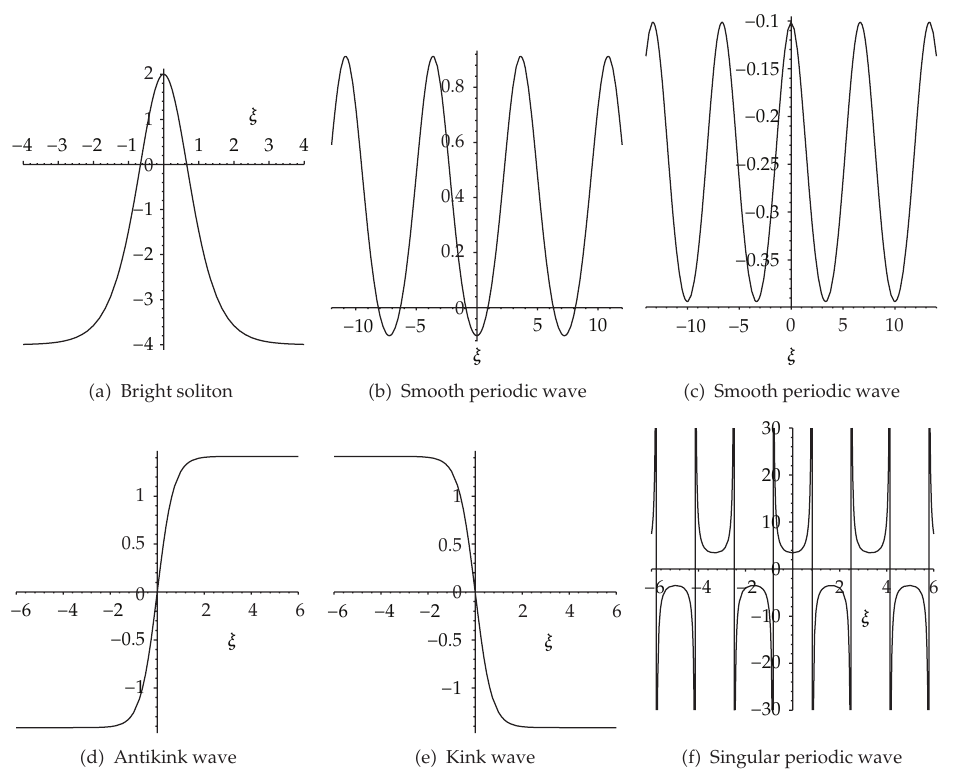
Figure 7: The graphs of six kinds of waveforms for solutions (cid:2) 3.59 (cid:3) , (cid:2) 3.60 (cid:3) , (cid:2) 3.61 (cid:3) , (cid:2) 3.63 (cid:3) , and (cid:2) 3.68 (cid:3) .